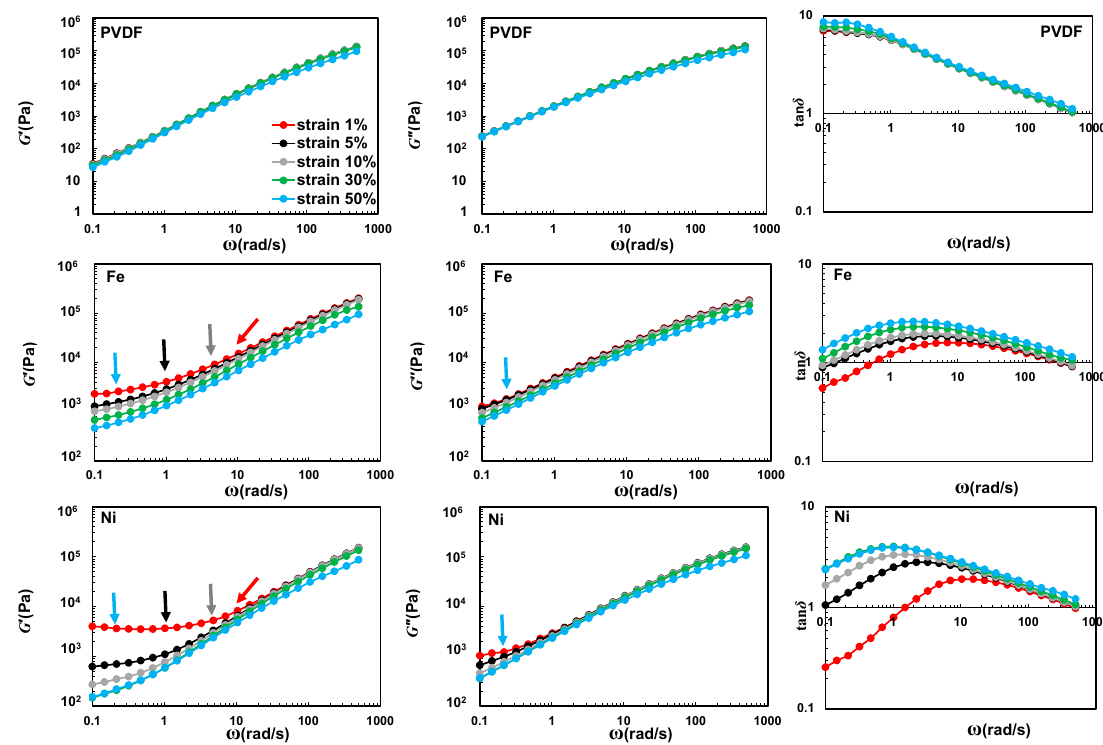
Figure 3. Dynamic moduli and damping factor of neat PVDF and N-CNT/PVDF nanocomposites containing 2.0 wt% of carbon nanotubes synthesized on different catalysts for strain amplitudes of γ 0 = 1, 5, 10, 30, and 50% using cone-plate geometry (truncation of 47 µ m) at 240 ◦ C. Data points highlighted by arrows will be compared with first order elastic e 1 and viscous v 1 Chebyshev coe ffi cients, respectively.